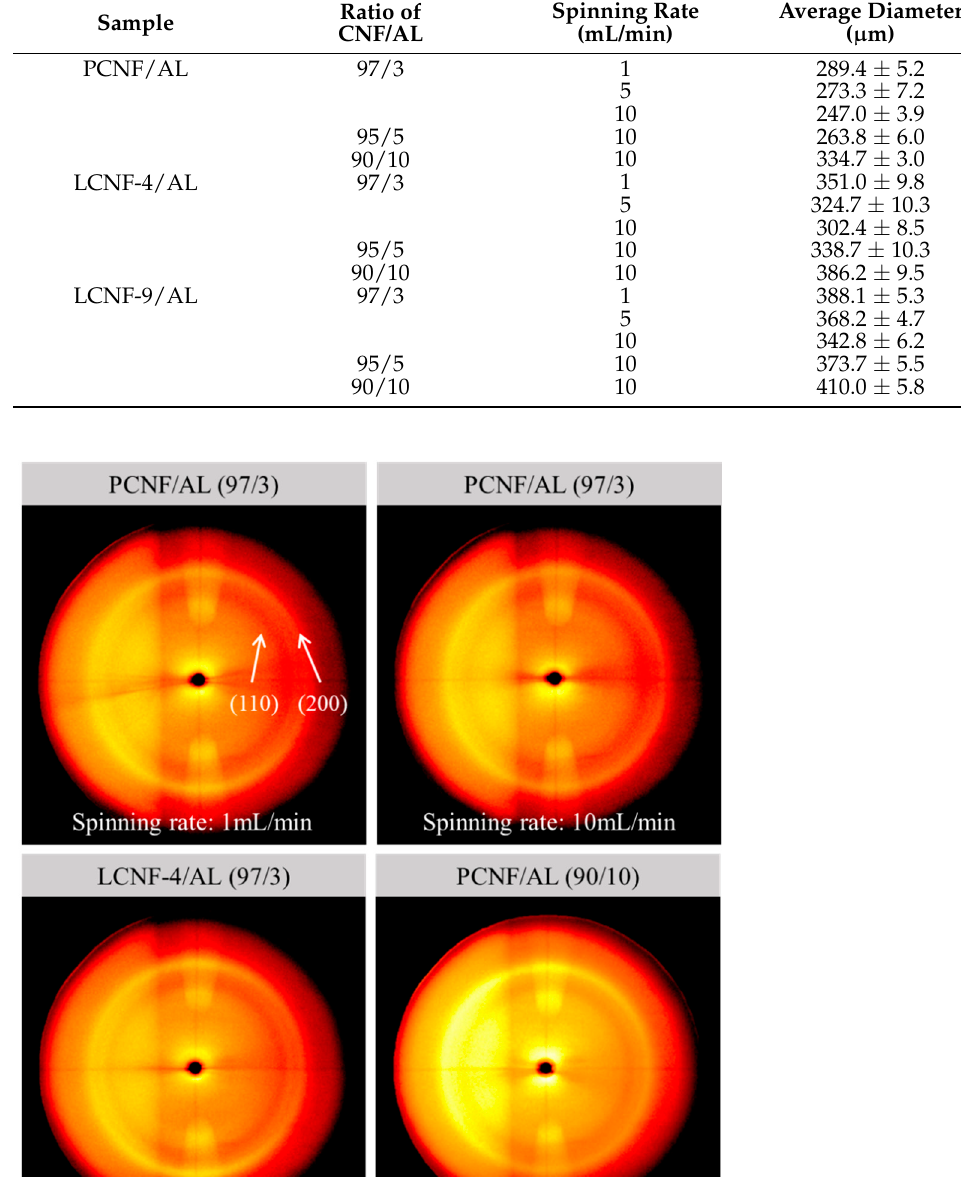
Table 3. Average diameter of wet-spun composite filaments from PCNF/AL, LCNF-4/AL, and LCNF-9/AL at different ratios of CNF/AL and spinning rates.